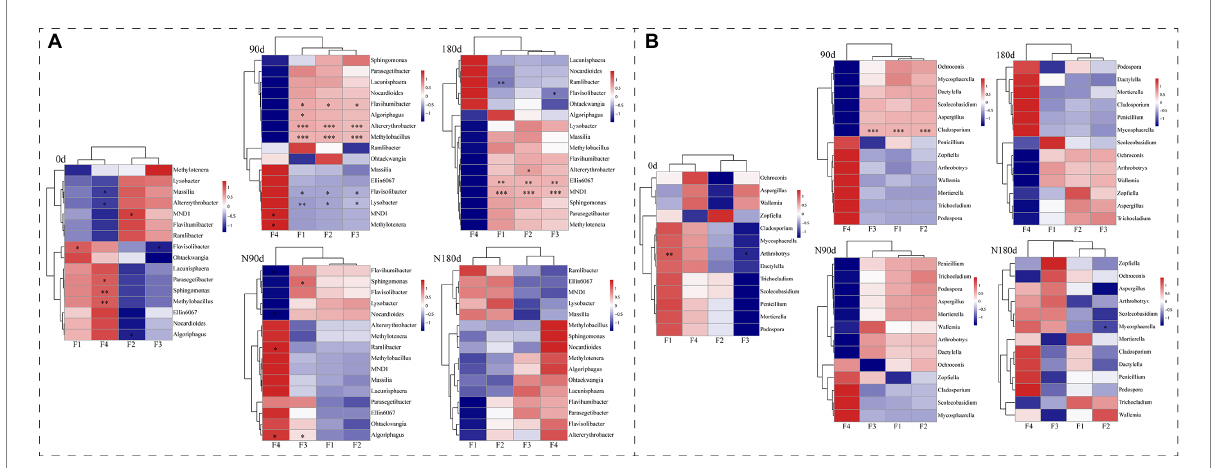
FIGURE 4 Correlation heat map of the relative abundance >2% bacterial genera (A) , fungal genera (B) , and four fractions of Cr in soil. X- and Y-axis are four fractions of Cr and genera, respectively. R in different colors to show, the right side of the legend is the color range of different r values. The value of p < 0.05 is marked with “ * ,” p < 0.01 is marked with “ ** ,” and p < 0.001 is marked with “ ***